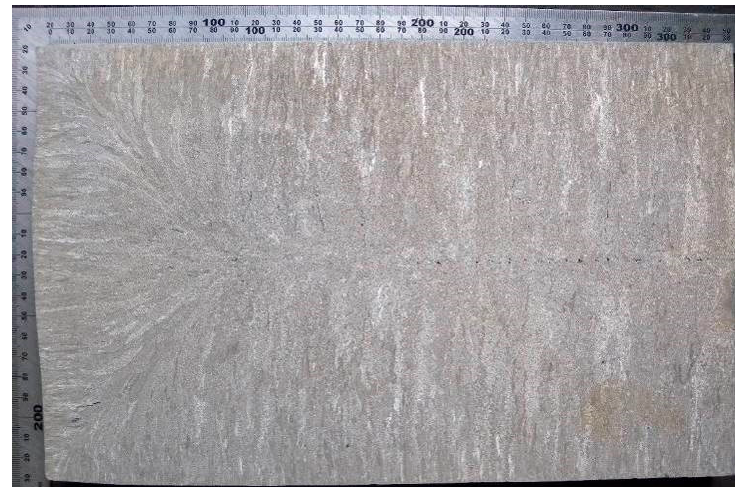
Figure 11. Macrosegregation examination of results of the proposed model.